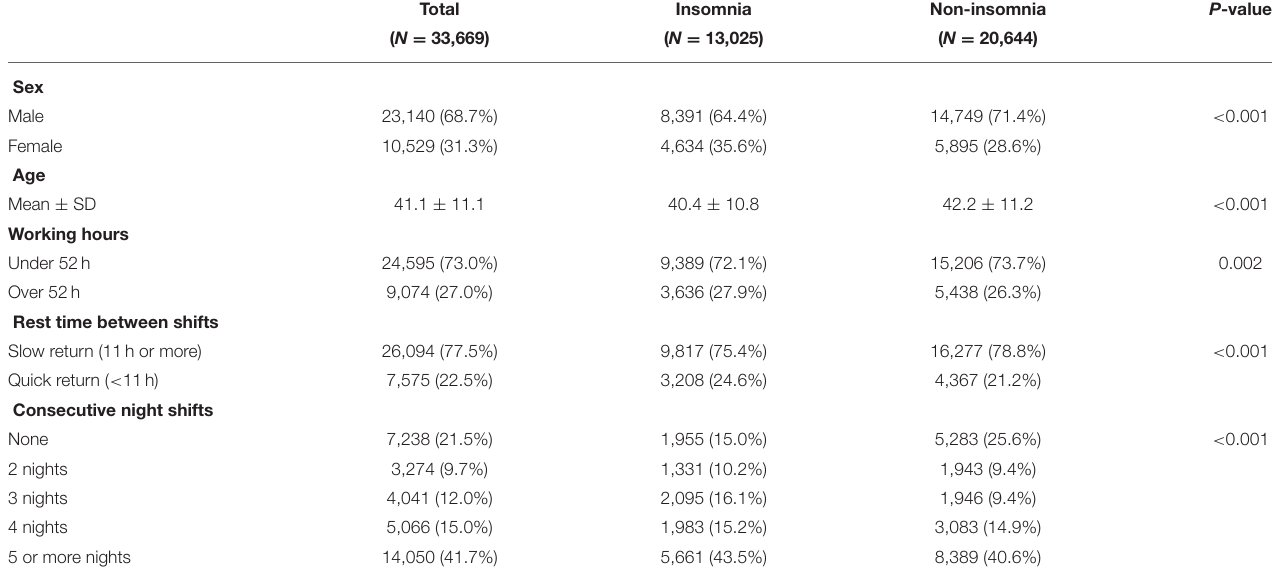
TABLE 1 | Baseline characteristics of the entire participants stratified by insomnia.